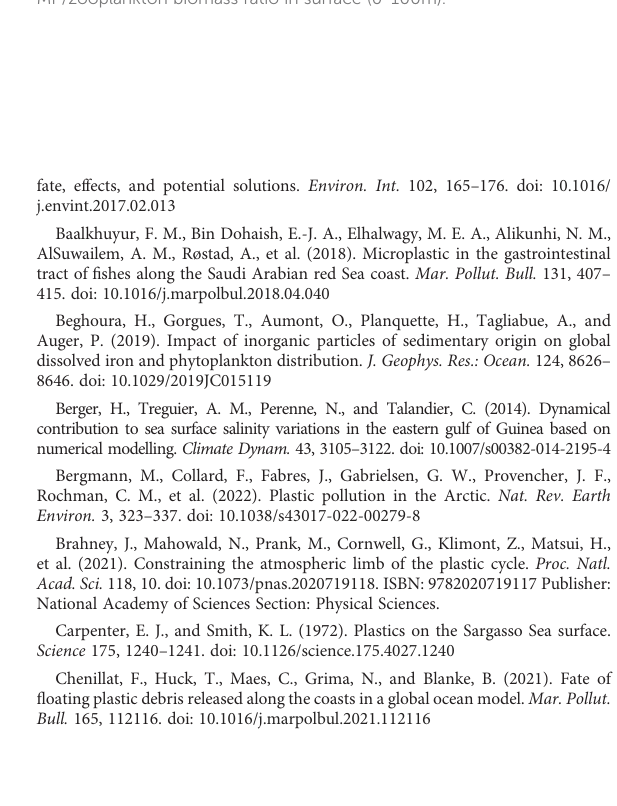
SUPPLEMENTARY FIGURE 1 MP concentration in the fi rst layer (0-10m) of the model in g/km 2 . SUPPLEMENTARY FIGURE 2 MPbudgetsineachdepthlayer(kt). (A) surface(0-100m), (B) mesopelagic (100-1000m), (C) deep (>1000m). SUPPLEMENTARY FIGURE 3 Maps of the relative proportion of neutral (A, D, G ) , fl oating (B, E ,H) and sinking (C, F ,I) MP in the surface (0-100m, a-c), mesopelagic (100- 1000m, D-F) and deep (>1000m, G – I) . SUPPLEMENTARY FIGURE 4 Zooplankton exposure to MP via active predation (A) and detritivory (B) . Both values are unitless (see Methods ). SUPPLEMENTARY FIGURE 5 MP/zooplankton biomass ratio in surface